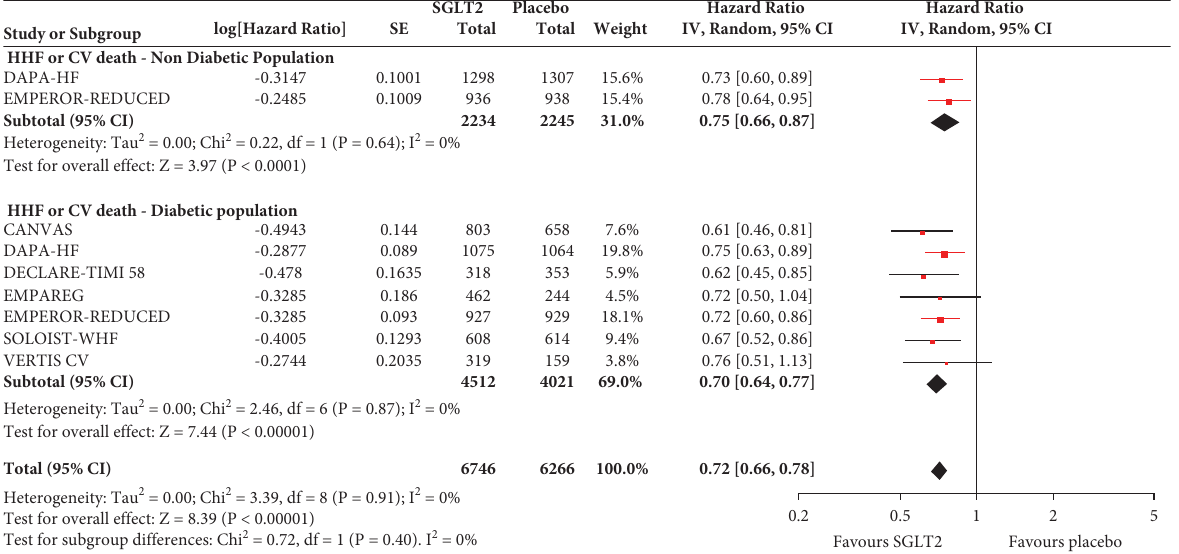
Figure 6: Subgroup analysis of the treatment effect SGLT2 inhibitors on hospitalisation for heart failure or cardiovascular death depending on baseline diabetes